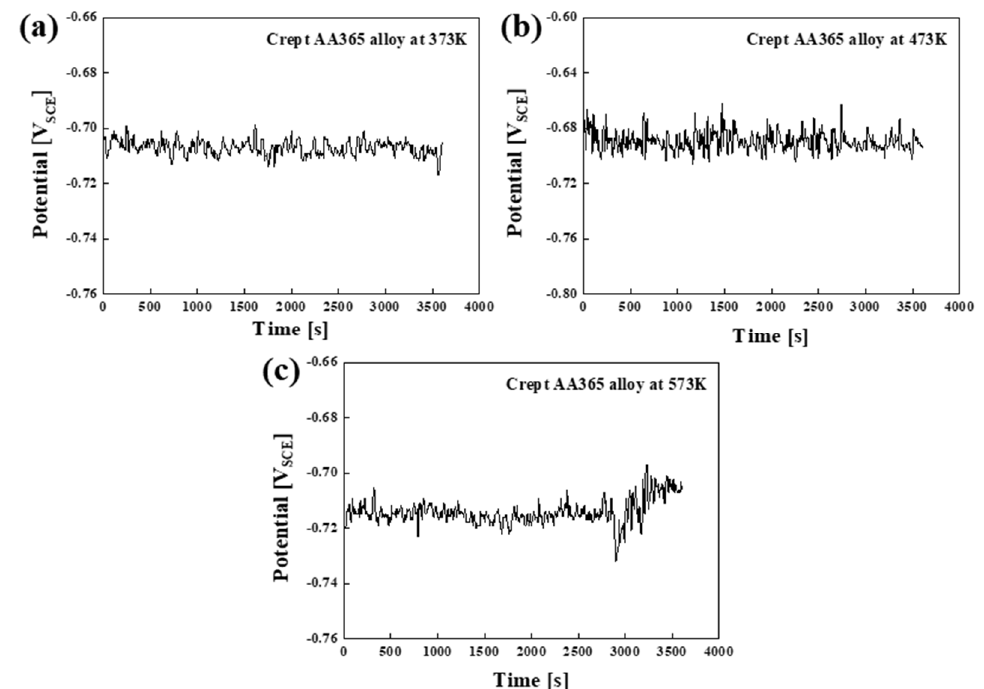
Figure 3. Variation of the open circuit potential (OCP) of crept AA365 alloys in 3.5 wt.% NaCl during a hour of immersion: ( a ) crept AA365 alloy at 373 K; ( b ) crept AA365 alloy at 473 K; ( c ) crept AA365 alloy at 573 K .